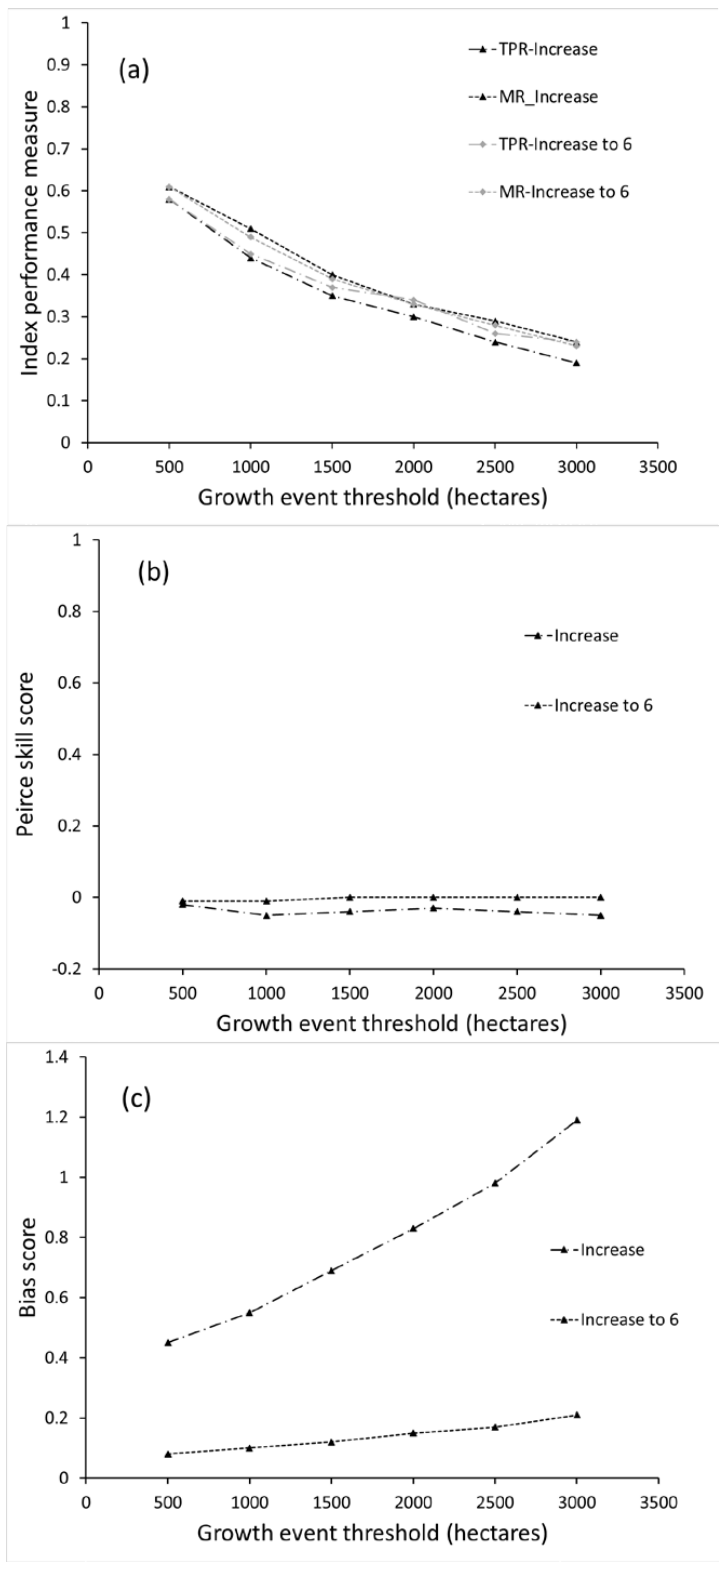
Figure 6. Summary scores for Haines Index increasing, and for Haines Index increasing to 6, for event growth thresholds from 500 to 3000 ha: ( a ) TPR and MR; ( b ) Peirce skill scores; ( c ) Bias